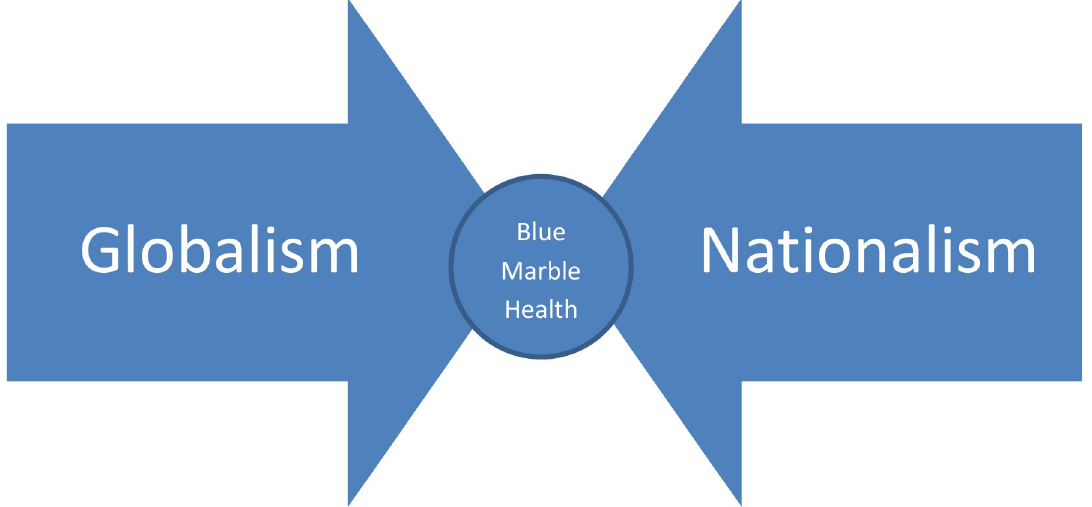
Fig 1. Finding common ground through blue marble